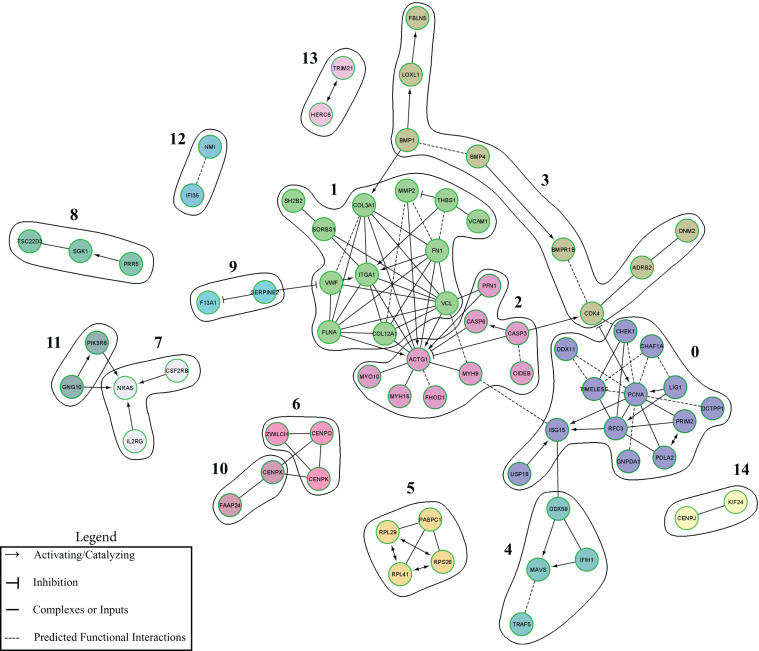
ReactomeFIViz-Derived Cluster Functional Interaction Network. Functional modules of unique up-regulated DEGs altered by candesartan treatment after TBI at 3 dpi in the hippocampus. Nodes in different network modules are shown in different colors. The modules listed are described in Supplementary Table 5.